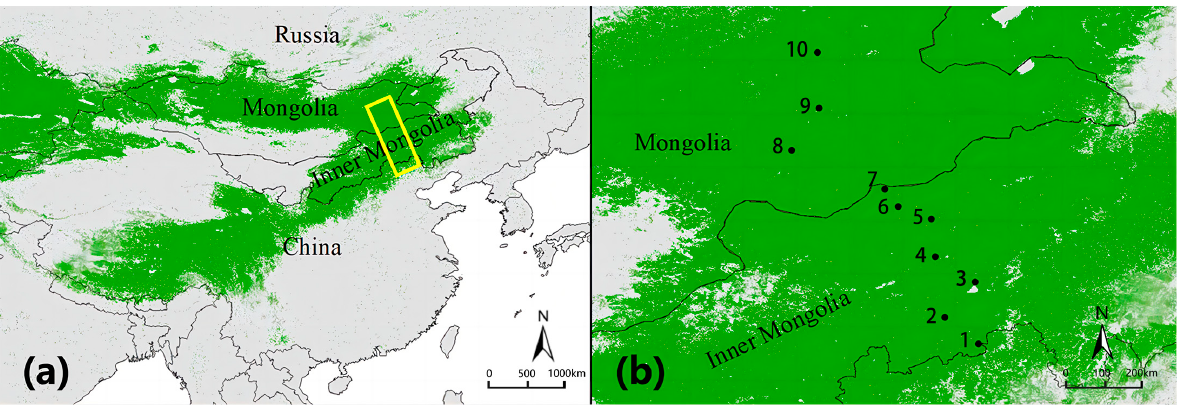
Figure 1. ( a ) Study area. Green indicates the distribution of the Eurasian Steppe. The yellow transect is the study area, corresponding to the Eastern Eurasian Steppe Transect (EEST) region. ( b ) Field sampling sites (black circles). Map is displayed on a WGS 1984 World Mercator projection (datum: WGS